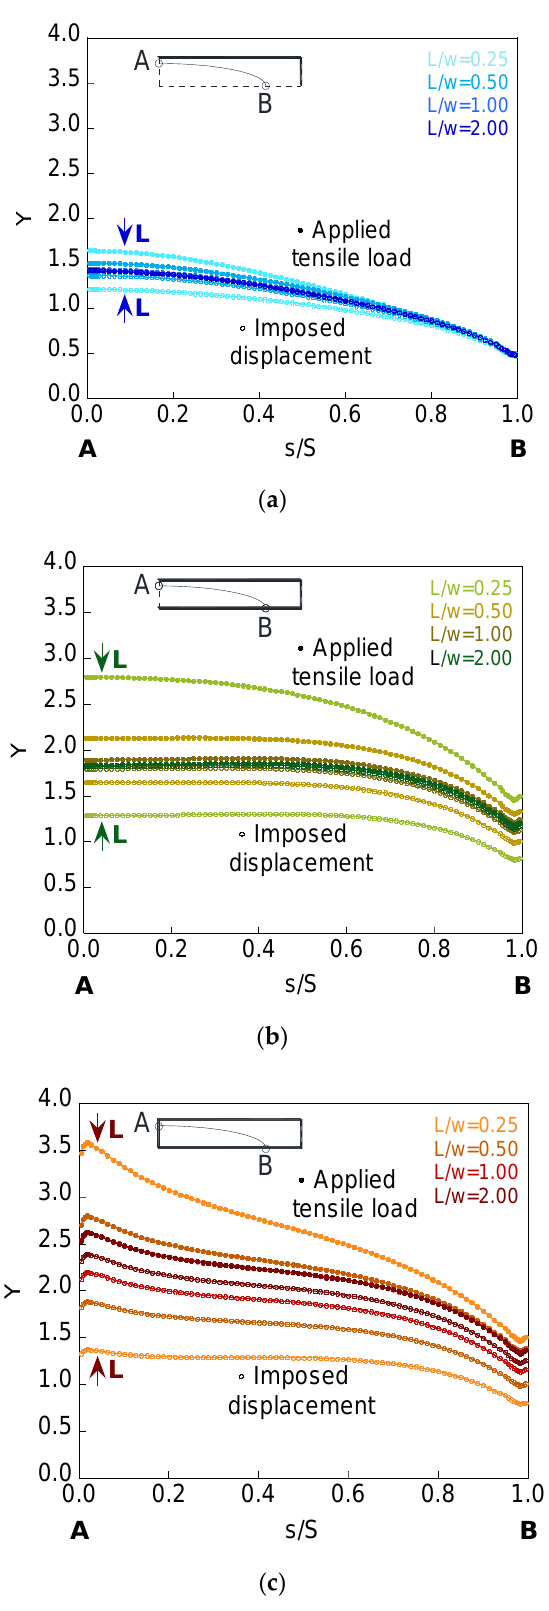
Figure 13. Dimensionless SIF for a crack of relative depth a / t = 0.8 and aspect ratio a / b = 0.2 in finite- thickness plates of relative lengths L / w = {0.25, 0.50, 1.00, 2.00} for the ( a ) embedded configuration, ( b ) superficial configuration, and ( c ) corner configuration.